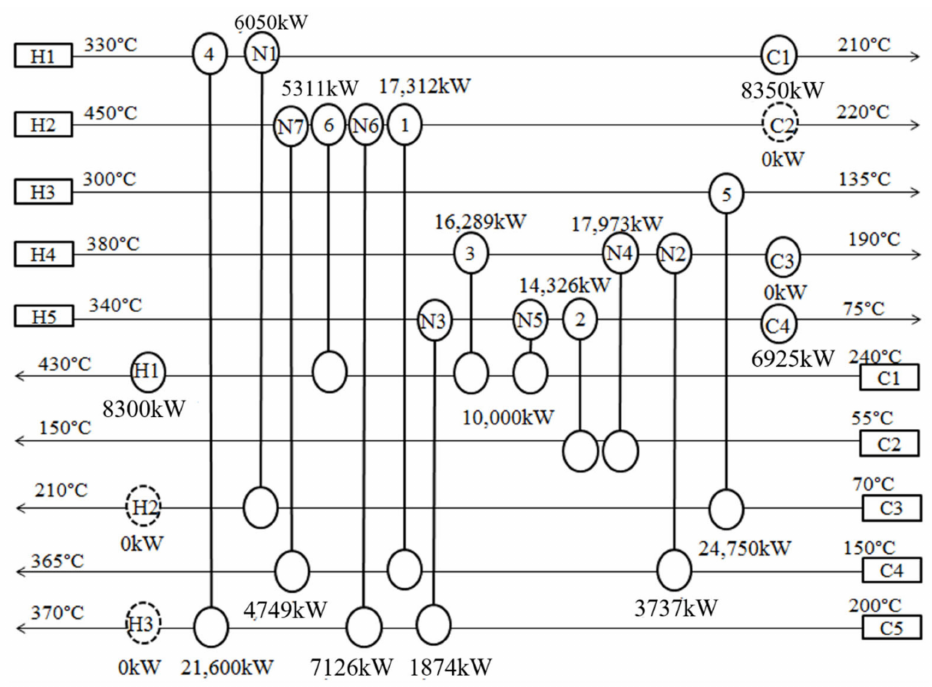
Figure 24. Best retrofit solution for case study 3 with application of plate heat